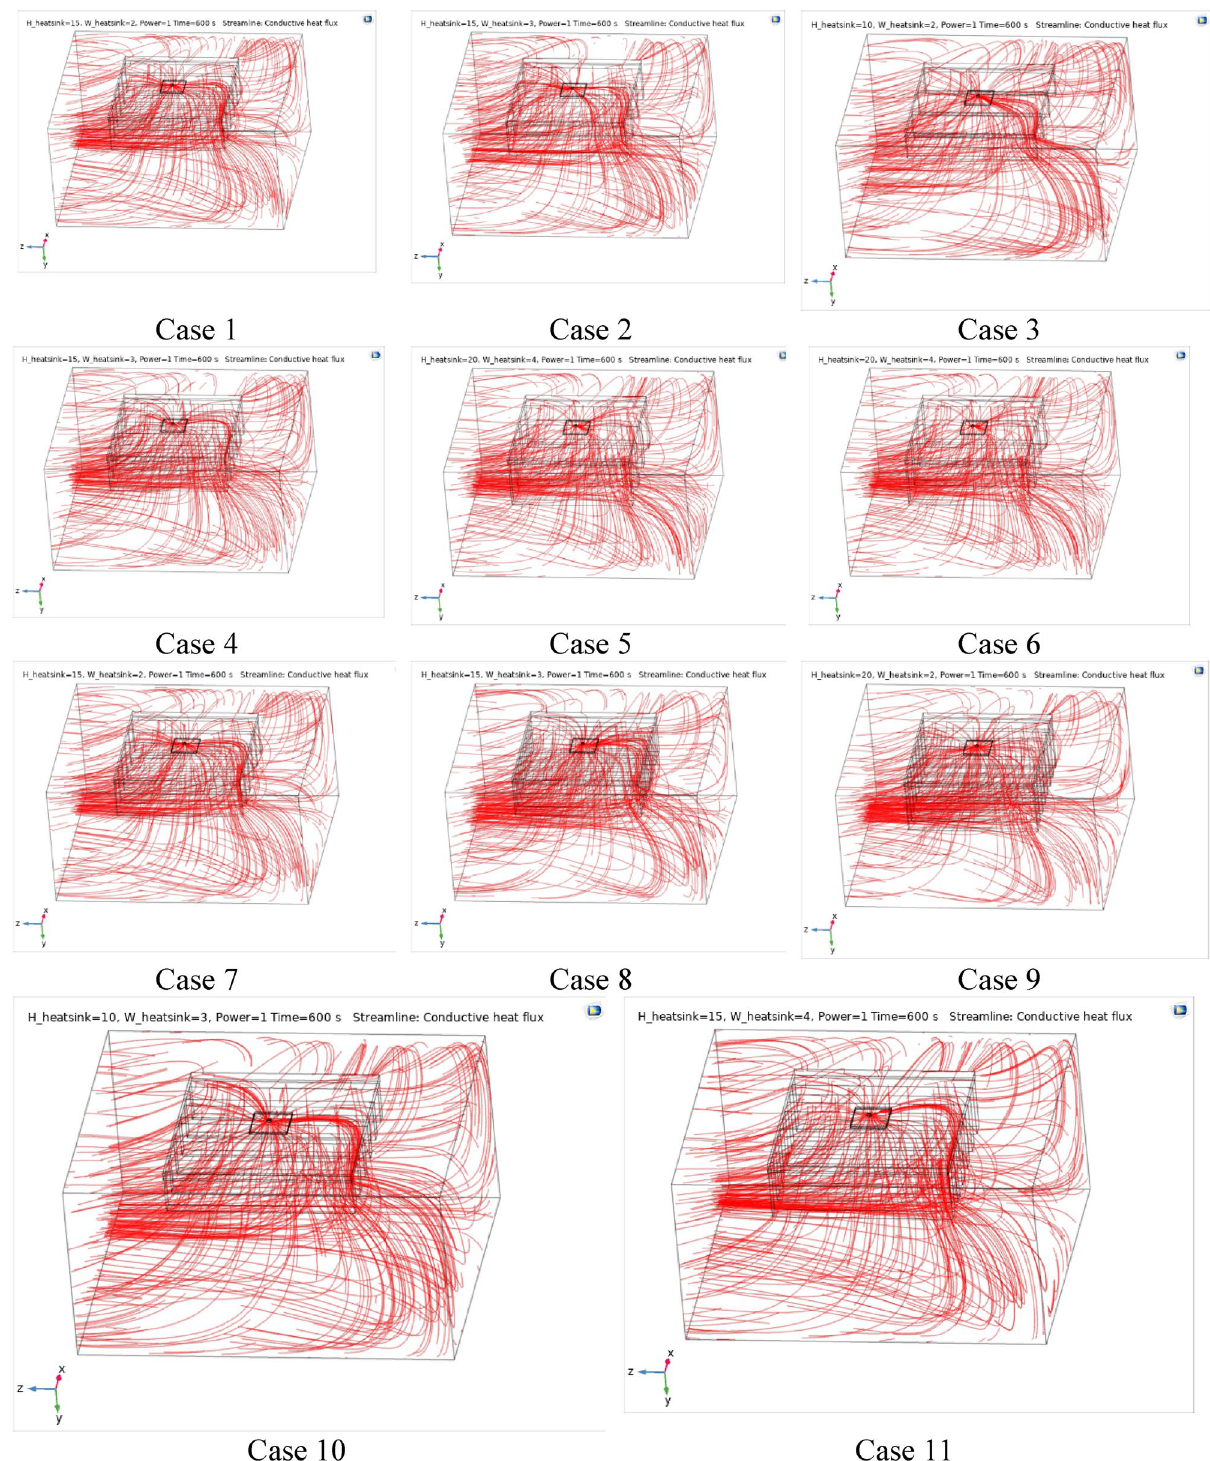
Figure 6. Streamline contours for the finned micro-channel of different geometries (11 Cases) (COMSOL Multiphysics 5.6, https:// www. comsol.